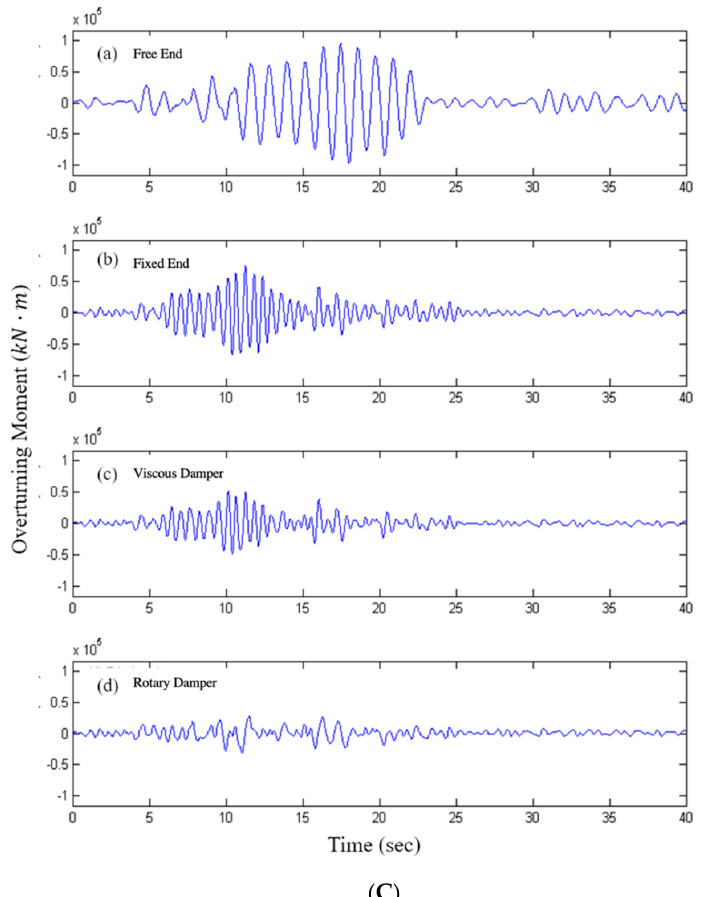
Figure 6. Time histories of displacement, base shear, and overturning moment. ( a ) Displacement response; ( b ) Base shear; ( c ) overturning moment.